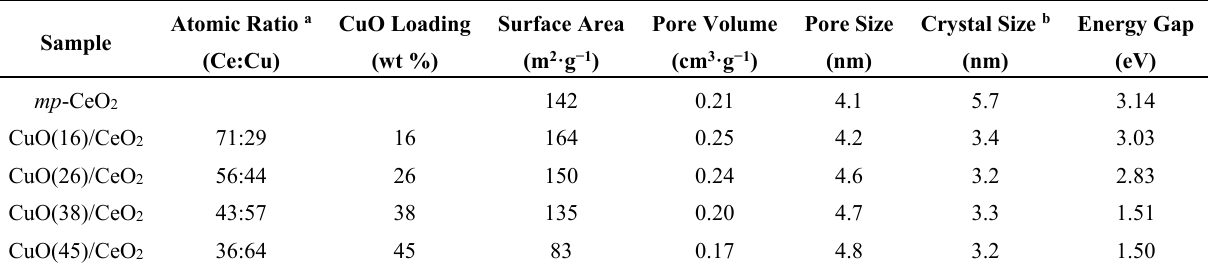
Table 1. Analytical data and textural properties of mesoporous CeO 2 ( mp -CeO 2 ) and CuO/CeO 2 composite